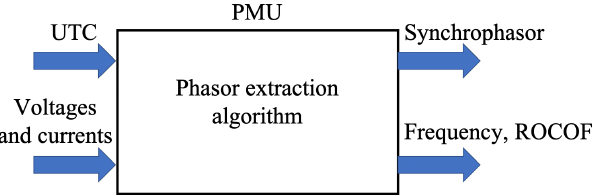
Figure 1. Simple schematic of the working principle of a PMU.